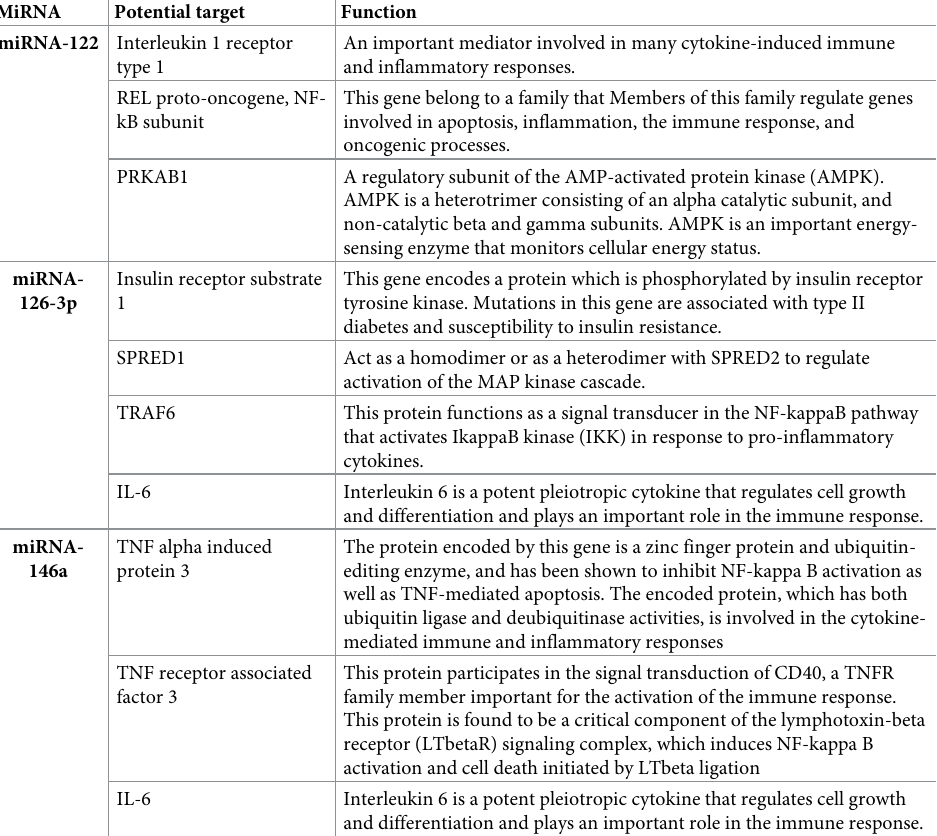
This protein is found to be a critical component of the lymphotoxin-beta receptor (LTbetaR) signaling complex, which induces NF-kappa B